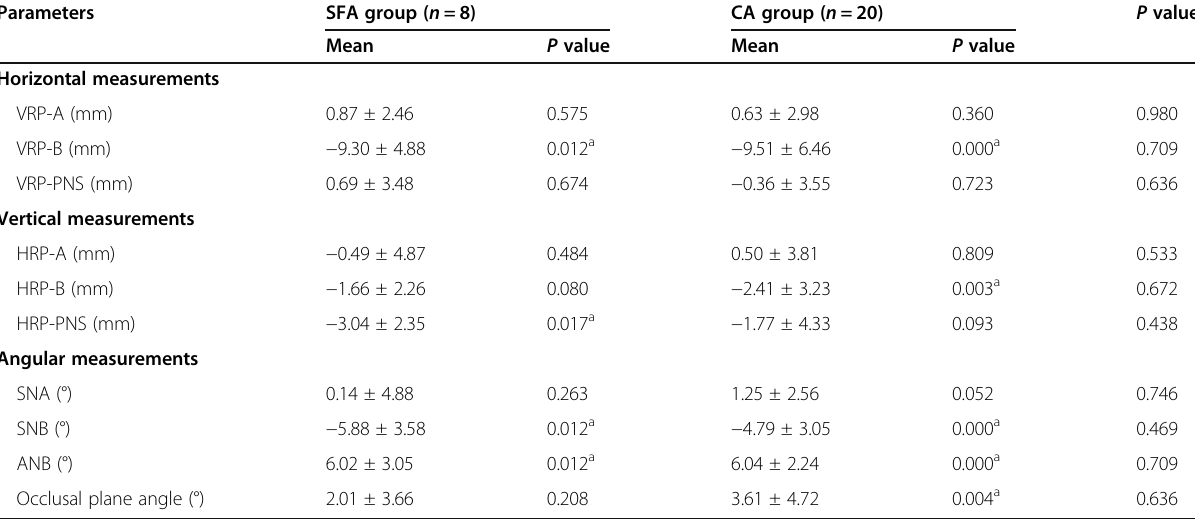
Table 3 Comparison of surgical change (T2-T1) on Experimental group and Control group